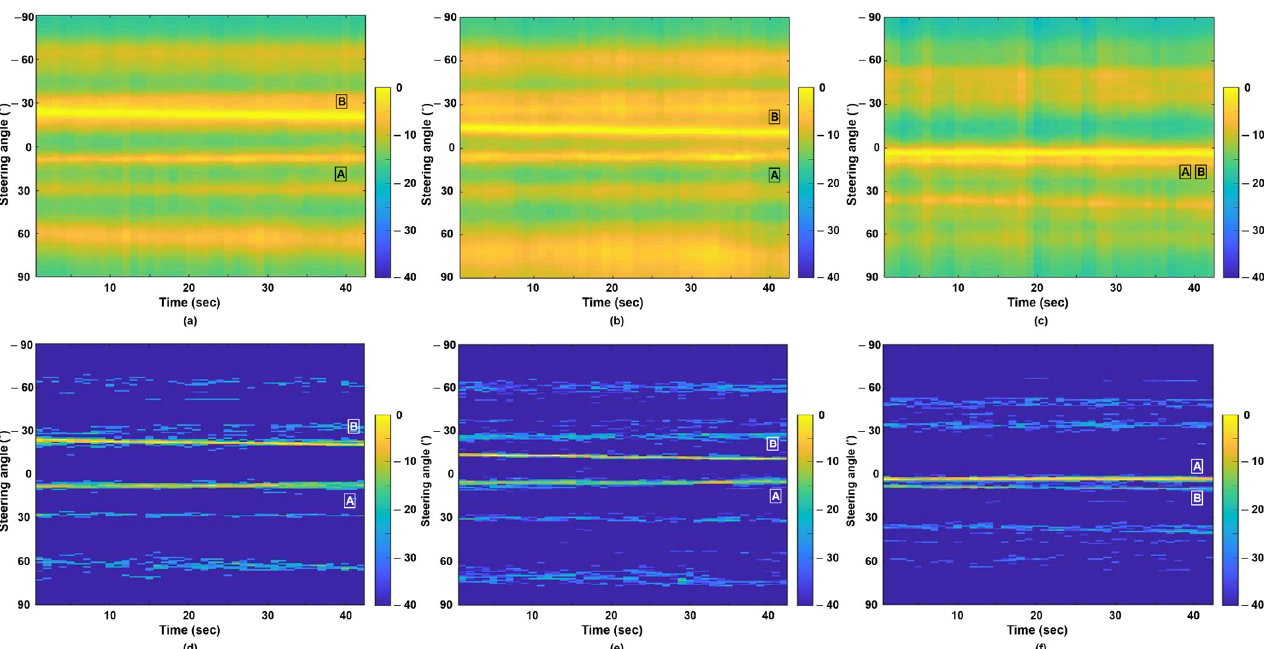
Figure 8. Detection results along time using ( a – c ) conventional detection method; ( d – f ) proposed detection method using the MM-SBL; at ( a , d ): 15 min; ( b , e ) 17 min; ( c , f ) 23 min.